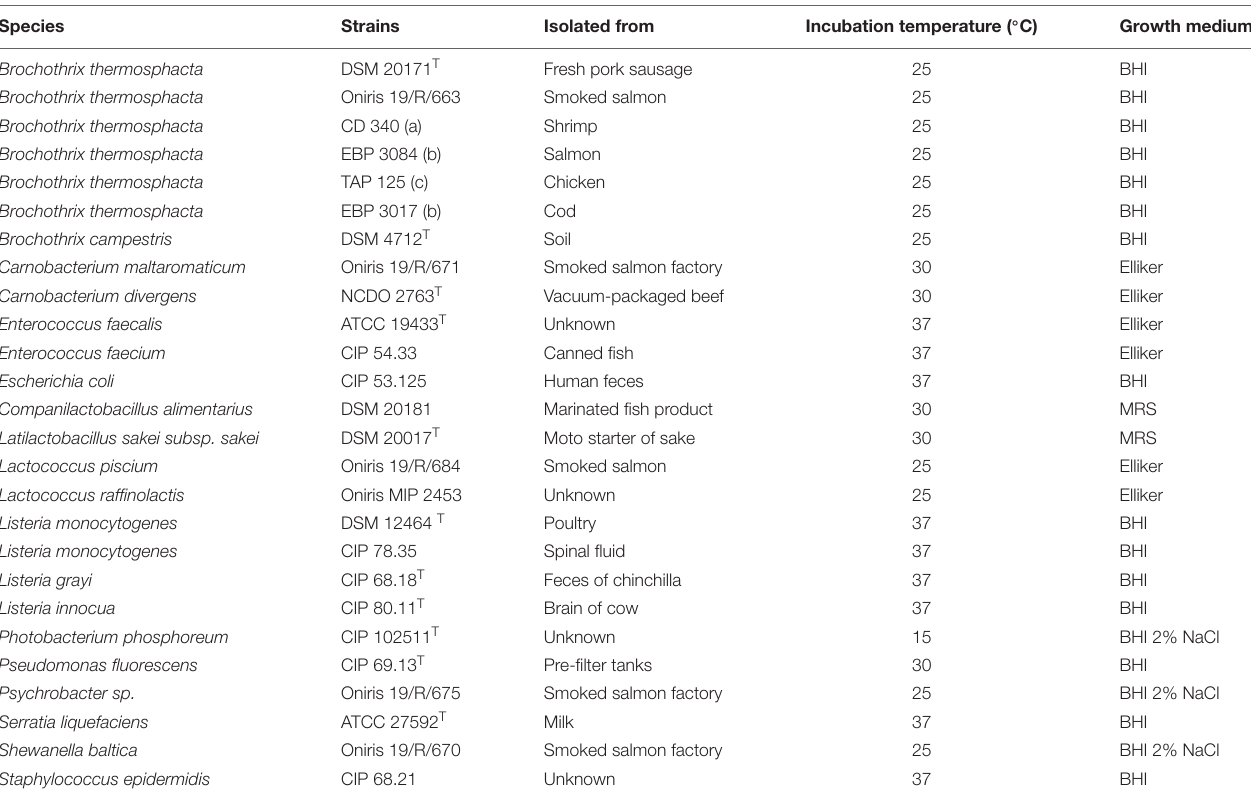
TABLE 1 | Bacterial strains used to assess the specificity of the qPCR